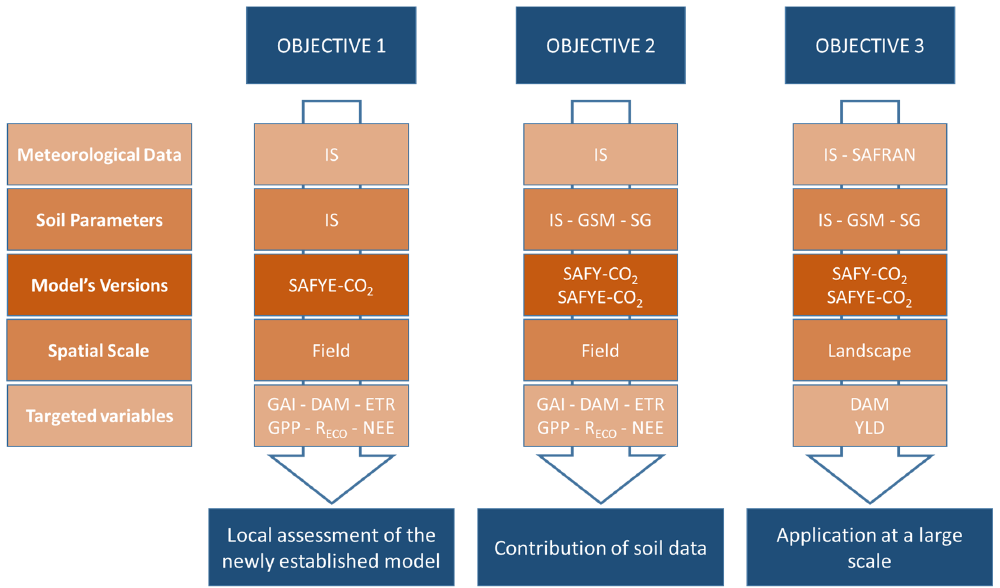
Figure 4. Summary of the validation strategy in terms of upscaling the SAFY-CO 2 and SAFYE-CO 2 models. IS is in situ, GSM is GlobalSoilMap, and SG is SoilGrids.